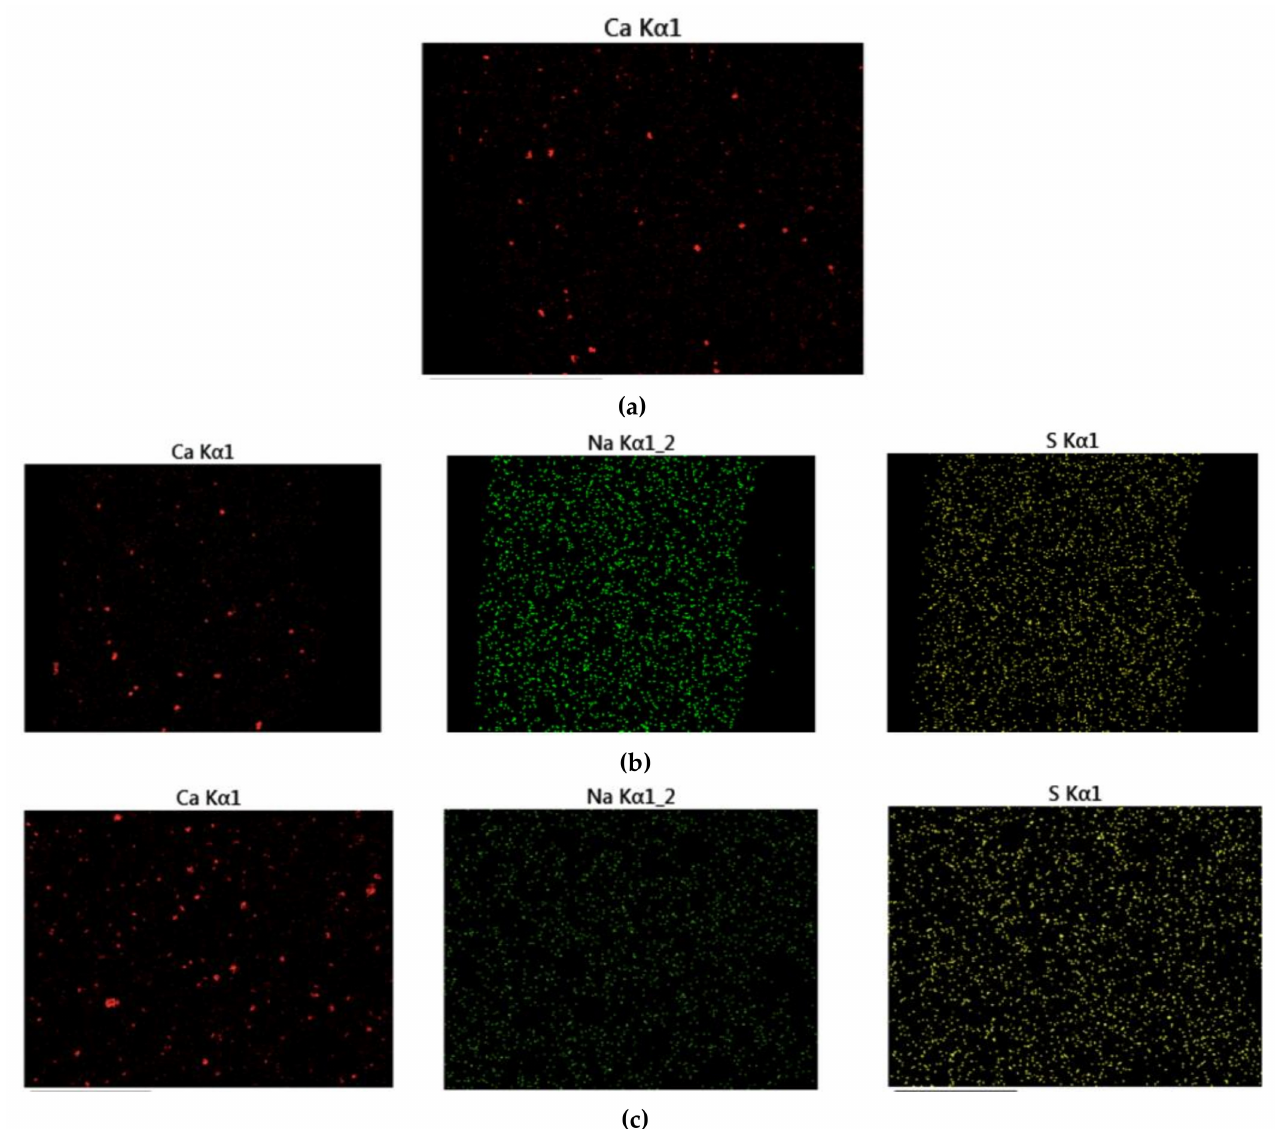
Figure 13. The EDX map of ( a ) epoxy-CaCO 3 coating, ( b ) epoxy-3 wt%SLS/CaCO 3 coating, and ( c ) epoxy-5 wt%SLS/CaCO 3 coating.